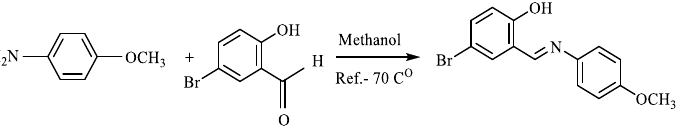
Table 1. Optimization of membrane composition of the proposed Hg 2+ -ISE based on the BMPMP ionophore.